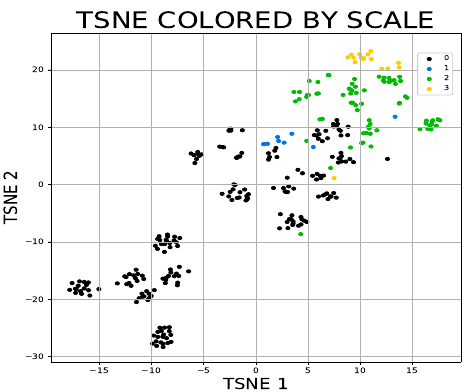
Figure 5. T-distributed stochastic neighbour embedding is also able to well separate subjects accord- ing to the severity of the clinical disability measured by the Scale for the Assessment and Rating of Ataxia score (the higher score the more severe